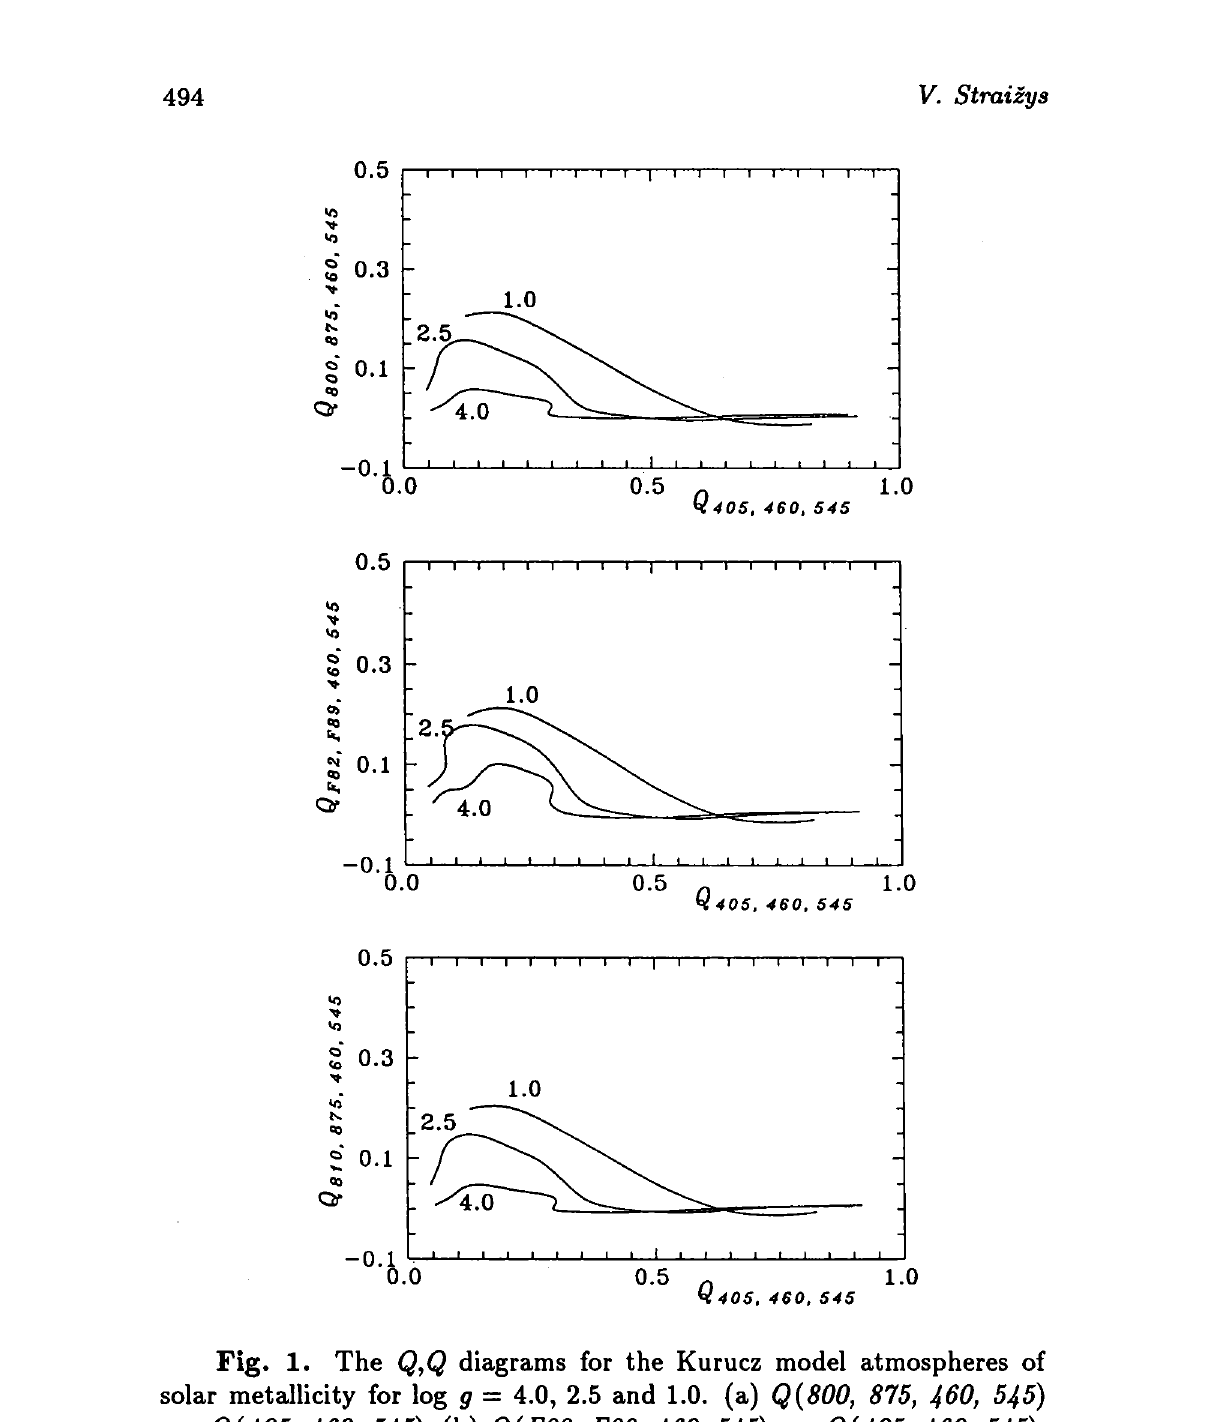
Fig. 1. The Q,Q diagrams for the Kurucz model atmospheres of solar metallicity for log g = 4.0, 2.5 and 1.0. (a) Q(800, 875, 460, 545) vs. Q(405, 460, 545); (b) Q(F82, F89, 460, 545) vs. Q(405, 460, 545)] (c) Q(810, 875, 460, 545) vs. Q(405, 460,